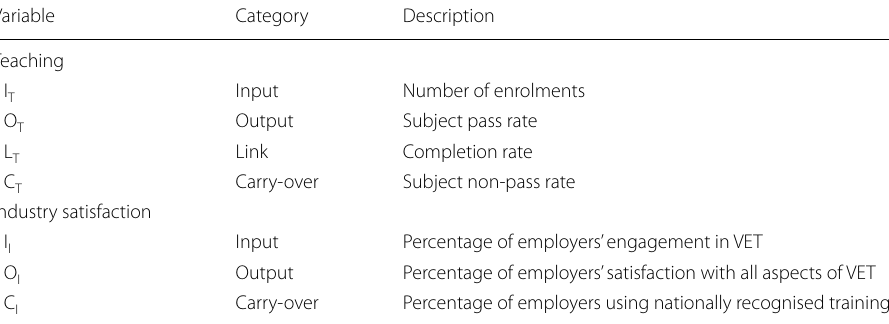
Table 2 Description of variables used in the empirical DNDEA model